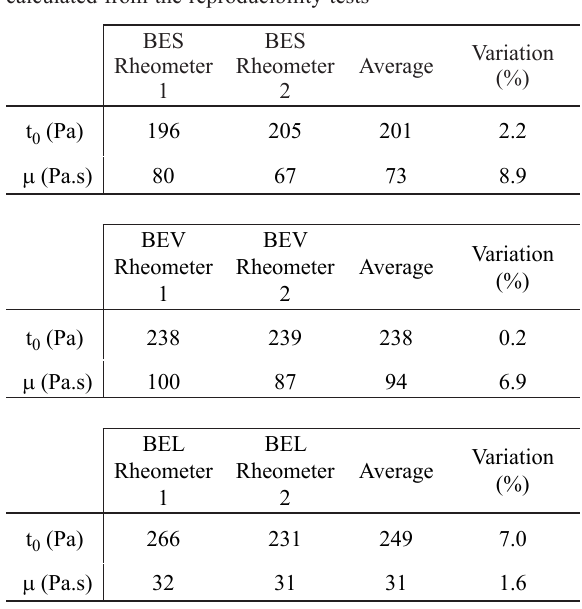
Fig. 16. Evolution of torques with different rotational speed for the concrete during the tests reproducibility on BES concrete, BEV and Table 4. Variation coefficients of the rheological parameters calculated from the reproducibility tests